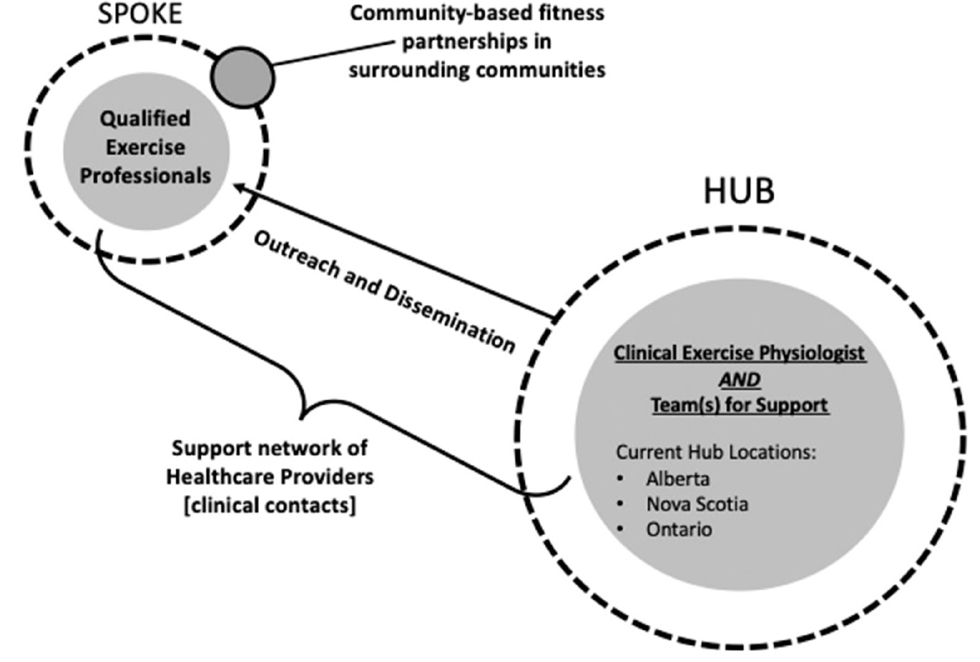
Figure 1. EXCEL “hub and spoke”